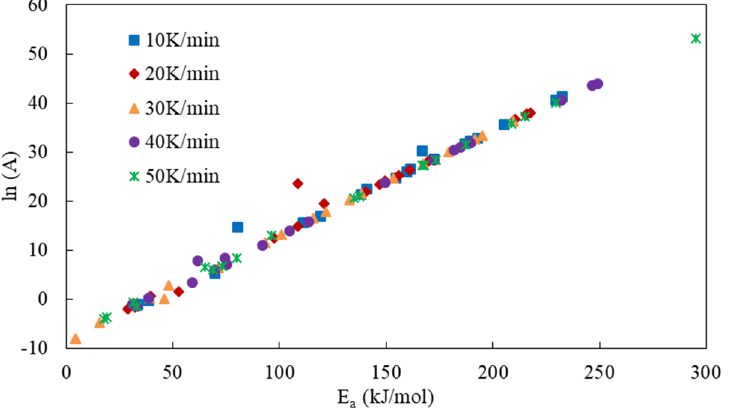
Figure 5. The relationship of the evaluated E a and A.